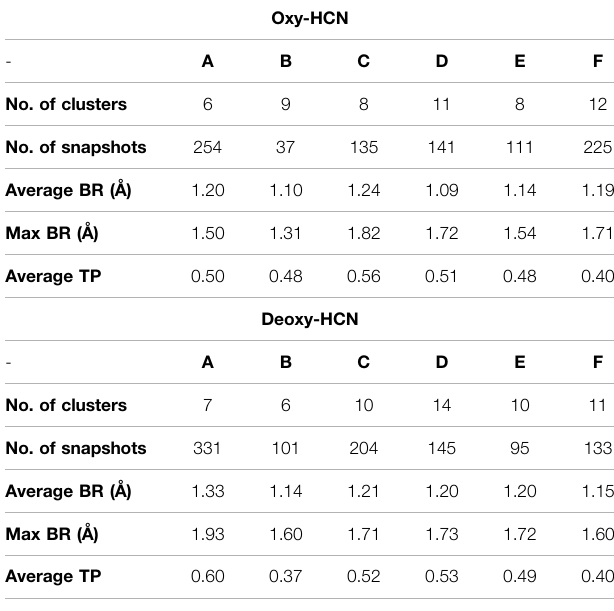
TABLE1| DynamictunnelpropertiesofDeoxy-andOxy-HCNidenti fi edbyCaver, using a probe radius of 1.0 Å and a clustering threshold of 10.0 (BR: bottleneck radius; TP: throughput).